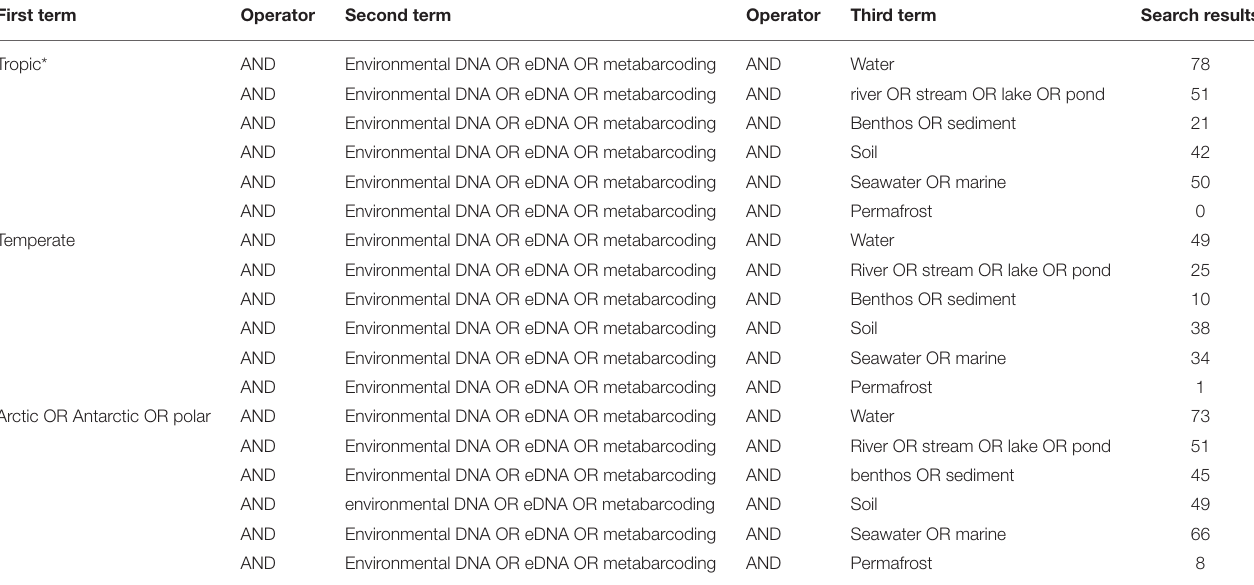
TABLE 2 | Results of Web of Knowledge searches returned for different environmental DNA/eDNA/metabarcoding, search terms (found anywhere in the article), associated with different sample types (water, river/stream/lake/pond, benthos/sediment, soil, seawater/marine, and permafrost) for each geographic region (tropic * , temperate,